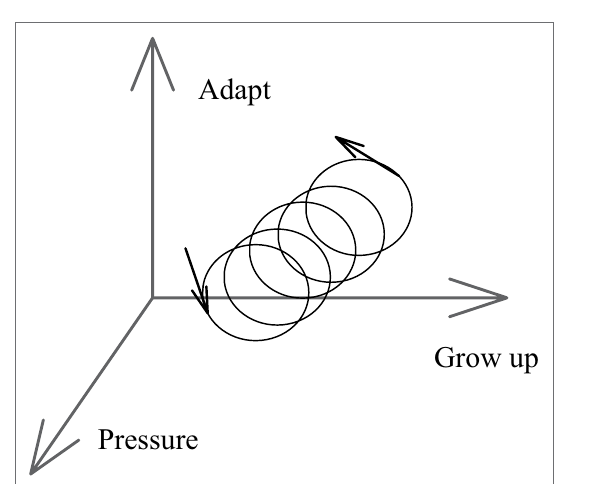
FIGURE 2 | Pressure-adaptation-dynamic-growth model.